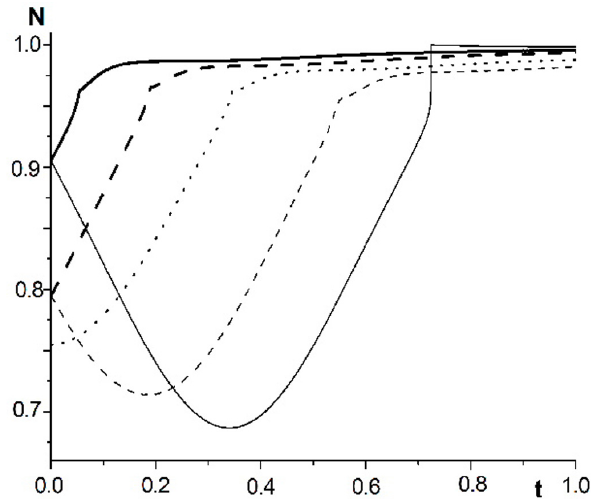
Fig. 3. Wave refractive indexes as functions of dimensionless time for the same five rays as in Fig. 1.